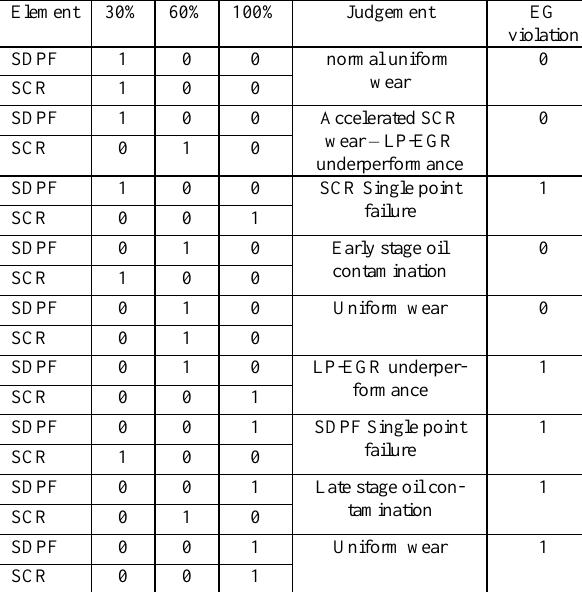
Table 7. Discretised failure combinations- symptoms and failure judge- ment, EG violation judgement